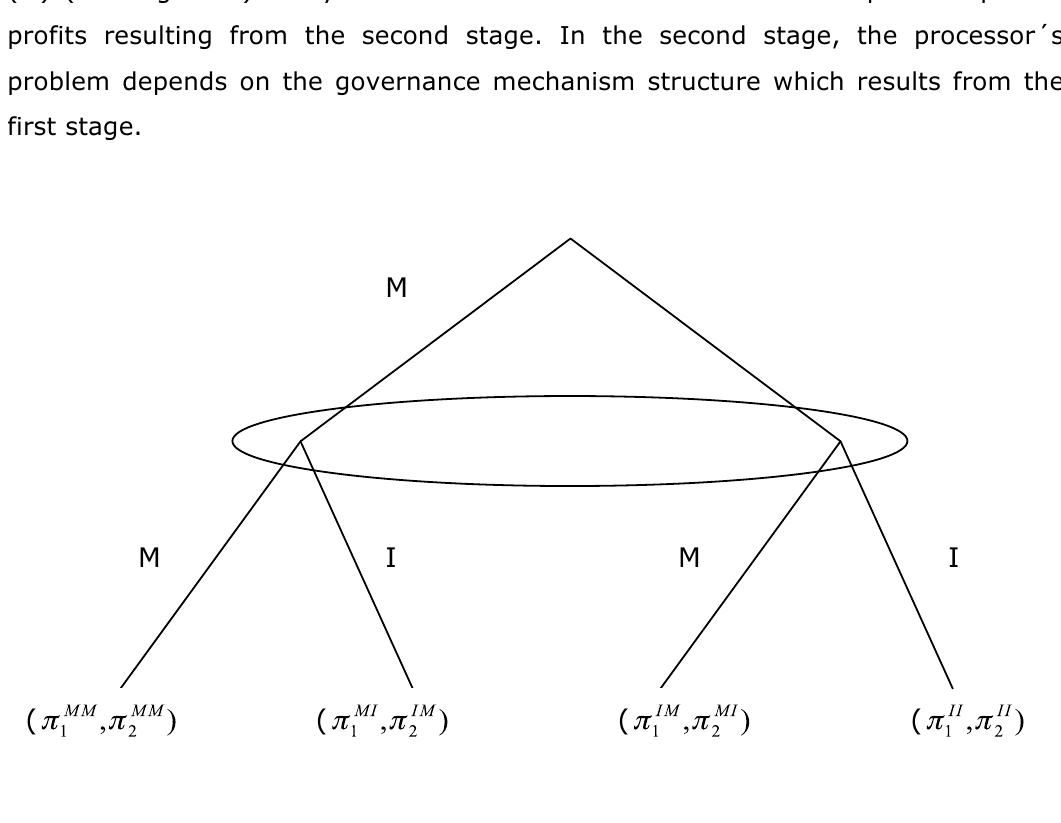
Figure 1. “Processors´ decisions in the first